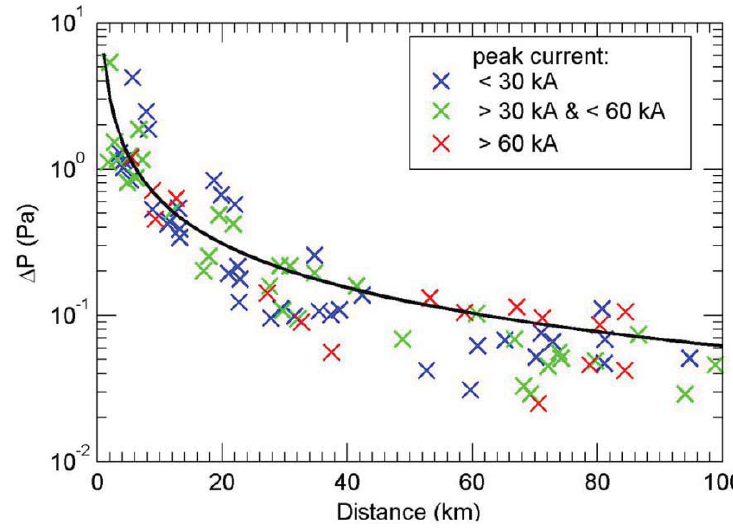
Figure 3. Lightning-generated infrasound amplitude versus ground distance. Amplitude of infrasound from lightning versus lightning distance (colored crosses) in a semi-log plot. The black line is the result of linear regression